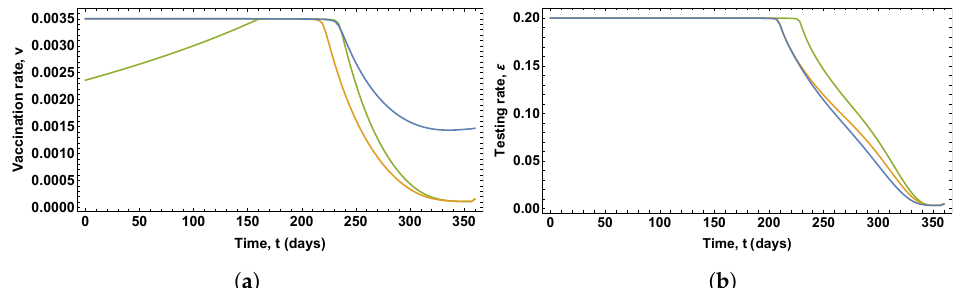
Figure 2. Optimal policies for scenario 1 (blue), scenario 2 (orange), and scenario 3 (green): ( a ) Opti- mal vaccination rates. ( b ) Optimal testing rates.